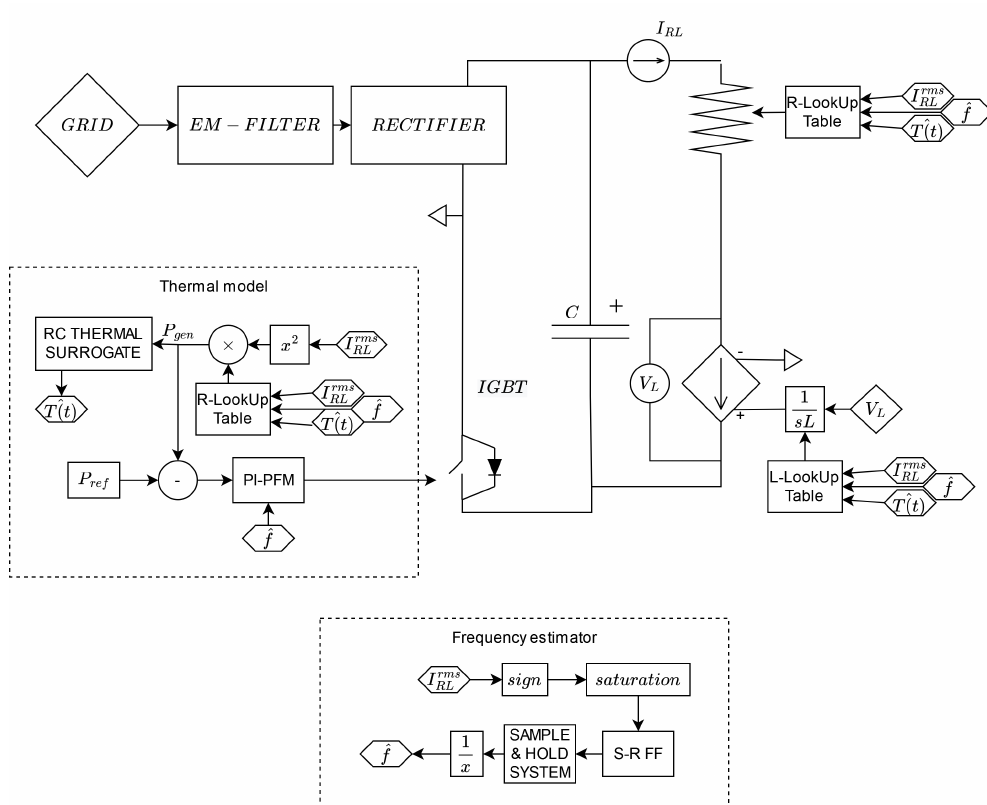
Figure 4. Inverter simulation system and PFM control with the thermal model and the integration of the equivalent